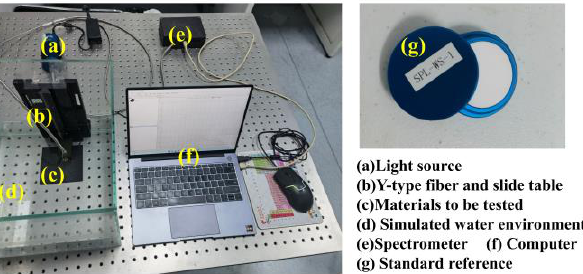
Figure 2. The hardware system developed for bionic fish recognition.